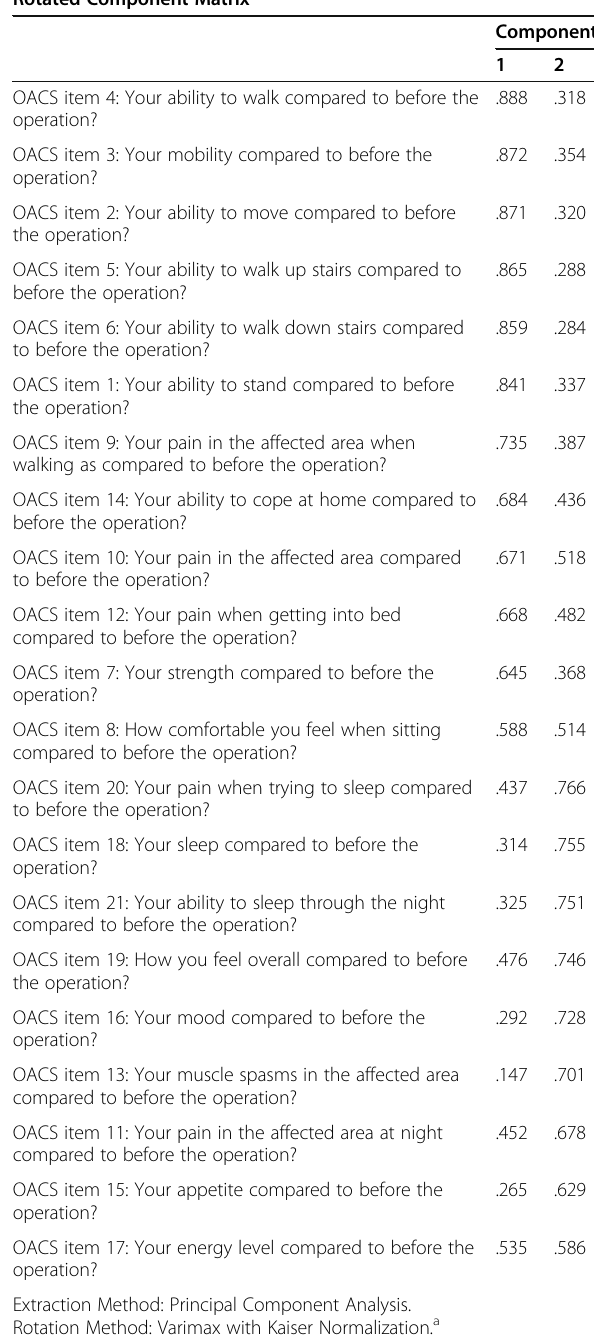
Table 8 21-item OACS day one item factor loadings Rotated Component Matrix